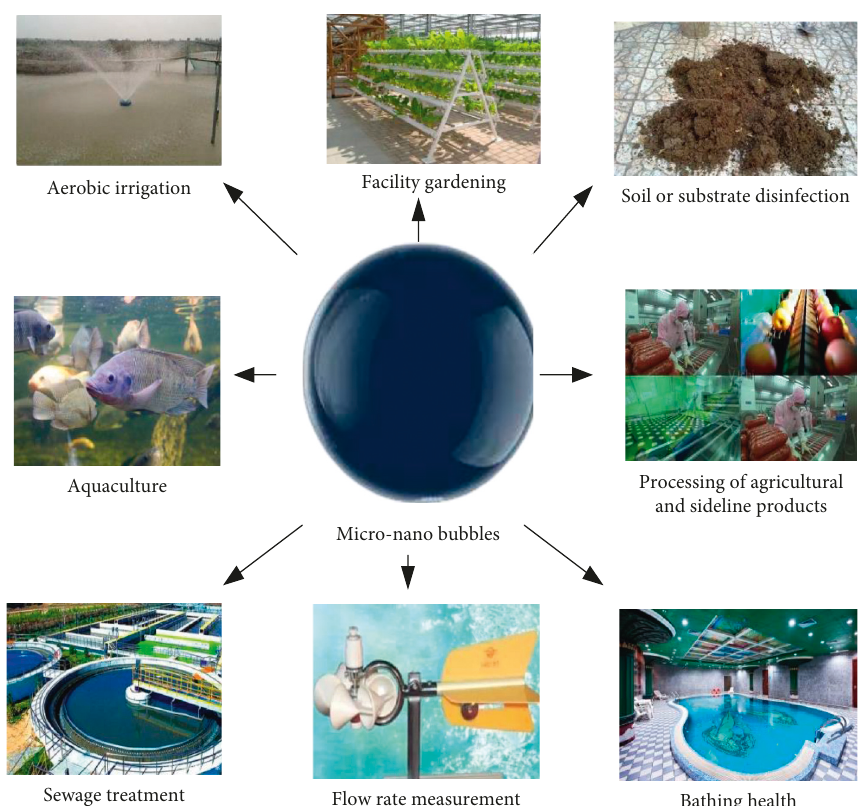
Figure 2: Application areas of micro-nano